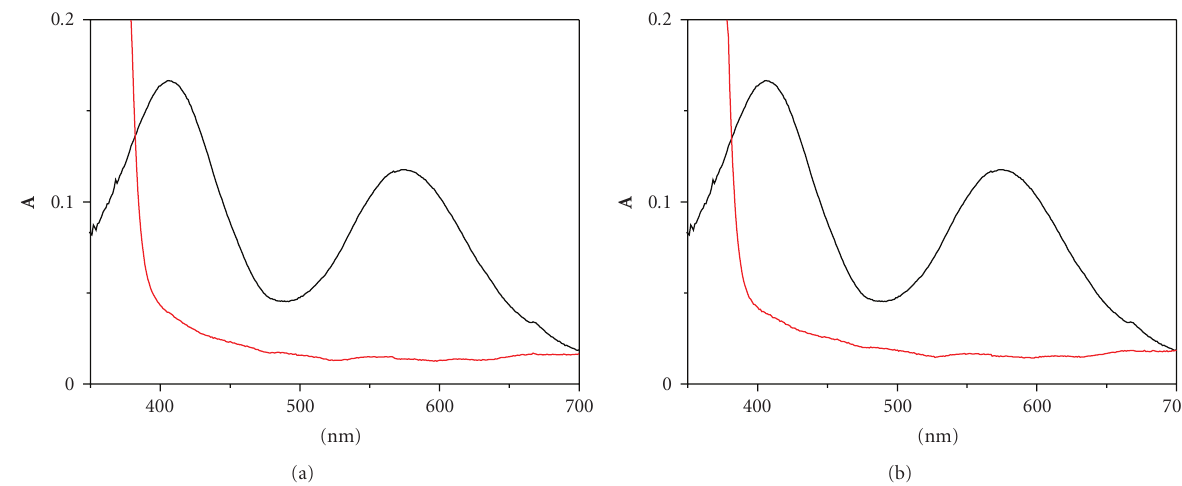
Figure 4: UV-vis spectra of Cr(III)/DHBA solutions: (a) [Cr(III)] = 9.0 · 10 − 3 M and [2,4-DHBA] = 9.0 . 10 − 3 M; (b) [Cr(III)] = 9.0 · 10 − 3 M and [2,5-DHBA] = 9.0 . 10 − 3 M.